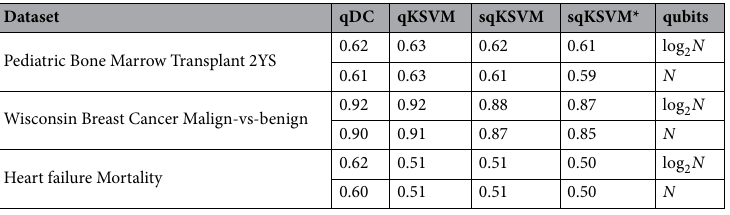
Table 2. Comparison of the cross-validation AUC performance for different data encodings. The qDC, qKSVM, and sqKSVM run on Pennylane simulator for N = 8 . For the log 2 N encoding, N features are encoded into log 2 N qubits with sequences of Pauli-Y gate rotations ( R y ) and CNOT s. In another strategy, N features are encoded into N qubits with sequences of the Hadamard gates, Pauli-Z gate ( R z ) rotations followed by nearest neighbor CNOT s. *The sqKSVM was also executed on the IBMQ Melbourne machine for reference